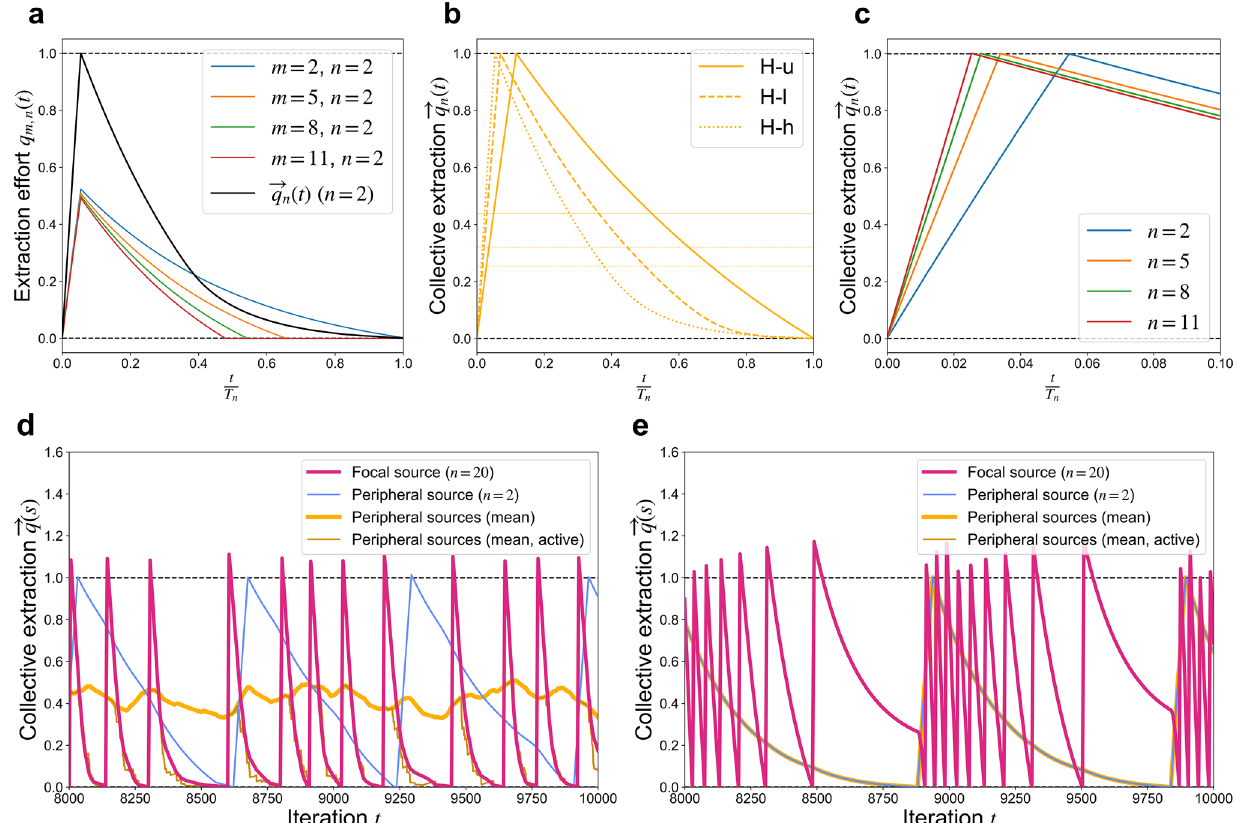
Figure 3. ( a ) Predicted time evolution of extraction levels q ( a , s ) through a depletion-remediation cycle for agents of various degrees m ( a ) from sources with degree n ( s ) = 2 within L–h networks based on a heterogeneous mean-field approach. ( b ) Effects of agent degree heterogeneity : Predicted time evolution of −→ q ( s ) with different types of agent degree heterogeneity (u, l, h) for sources with degree collective extraction n ( s ) = 2 within H networks; ( c ) Role of source degree : Predicted time evolution of collective extraction sources of various degree n ( s ) within L-l networks. ( d ) Dynamics of collective extraction from simulation on star network with randomized initial conditions ( u = 1 , k = .01 ; “Active” indicates that peripheral-source extraction values are set to zero for “inactive” agents whose current extraction from the focal source is zero). ( e ) Dynamics of collective extraction from simulation on star network with initial conditions synchronized such that all sources have the same collective extraction, providing an exaggerated illustration of how lower-degree sources can slow the remediation times of higher-degree